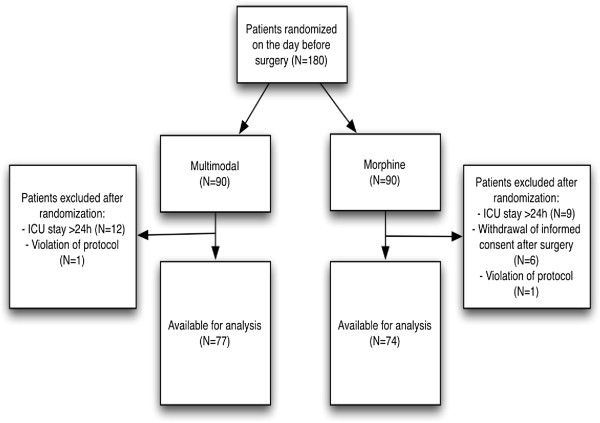
Study flow-chart.